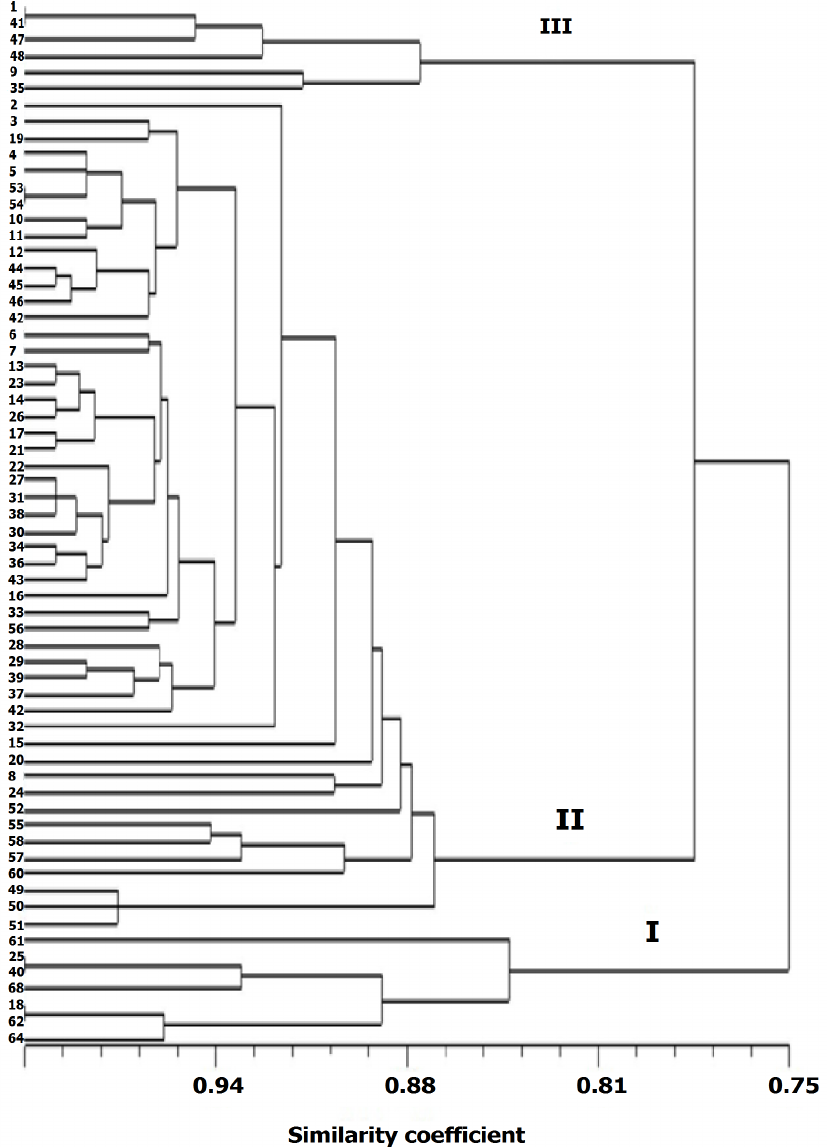
Fig. 1: Dendrogram of the 57 wild grown apricot genotypes using UPGMA method obtained from SRAP